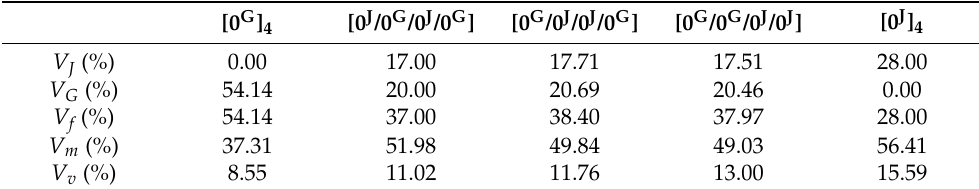
Table 1. Volume fraction of the constituents in the laminates.